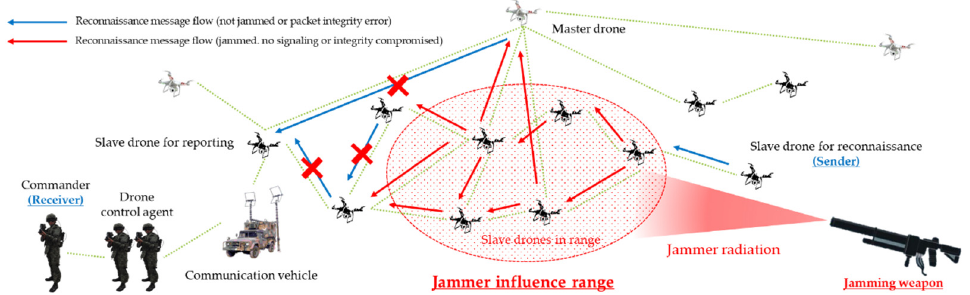
Figure 6. A multi-layered jamming scenario for a reconnaissance report in a swarming communication